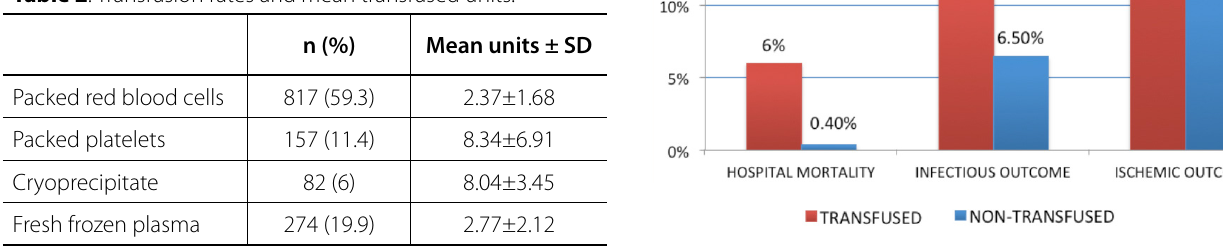
Table 2 . Transfusion rates and mean transfused units.